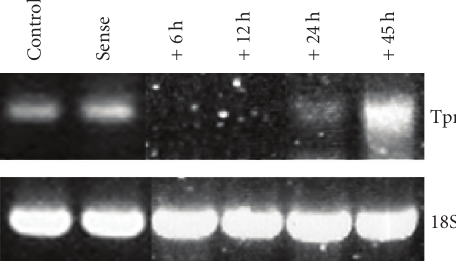
Figure 5: Transient knockdown of Tpr mRNA as monitored by semi-quantitative PCR. Antisense oligonucleotide TprB was microinjected into the D macromere of ∼ 50 embryos, and ∼ 12 embryos were harvested 6 (stage 6), 12 (stage 7), 24 (early stage 8) and 45 (mid-stage 8) hours later, respectively. Tpr mRNA levels were apparent by 24 hours post-injection in proliferated embryos. Control (no injection) and sense (TprC) microinjections were conducted in the same experimental clutch and harvested at 6 (stage 6) and 12 (stage 7) hours post-injection, respectively. Lanes were normalized with 18S rRNA